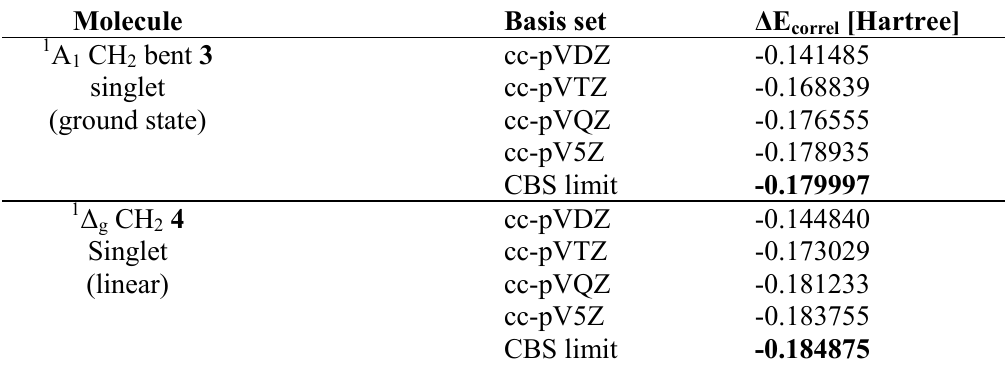
Figure 2. Exponential behaviour of correlation energies of the triplet 3 B ( 1 ) and the singlet 1 A CH 2